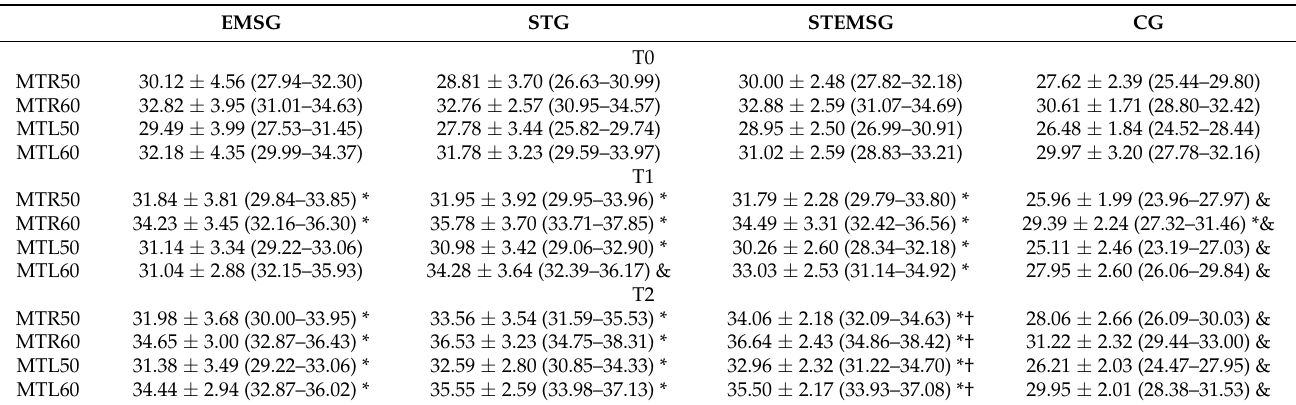
Table 3. Mean ± standard deviation (Confidence interval at 95%) of the both arms MT, in the different groups and